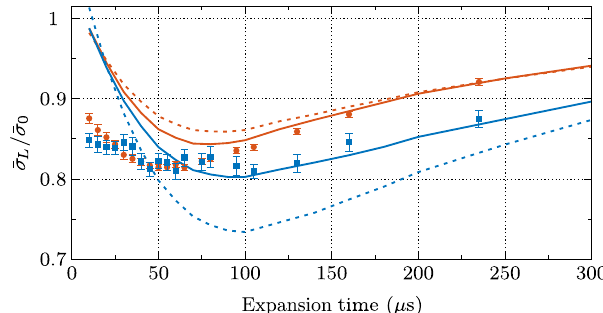
FIG. 7. Simulations of the relative average transverse width ¯ σ = ¯ σ 0 of a BEC illuminated after different expansion times. The L solid lines show the compression calculated with the full atom- light potential from Eq. (9) (used also for Fig. 3), while the dashed lines use the lowest-order approximation given in Eq. (5). The blue (red) lines are for detuning Δ ¼ þ 100 Γ ( Δ ¼ − 392 Γ ), atom number N ¼ 6600 (7450), and saturation s ¼ 708 × 10 −